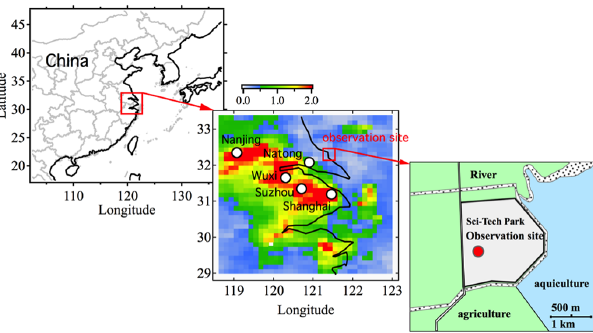
Figure 1. Geographic location of the observation site and the spatial distribution of monthly mean NO x column density (unit: × 10 6 moleculecm − 2 , the data were derived from OMI observa- tions, DOMINO version 2.0, http://www.temis.nl/airpollution/no2. html) during the field campaign period and the surrounding envi- ronment at the